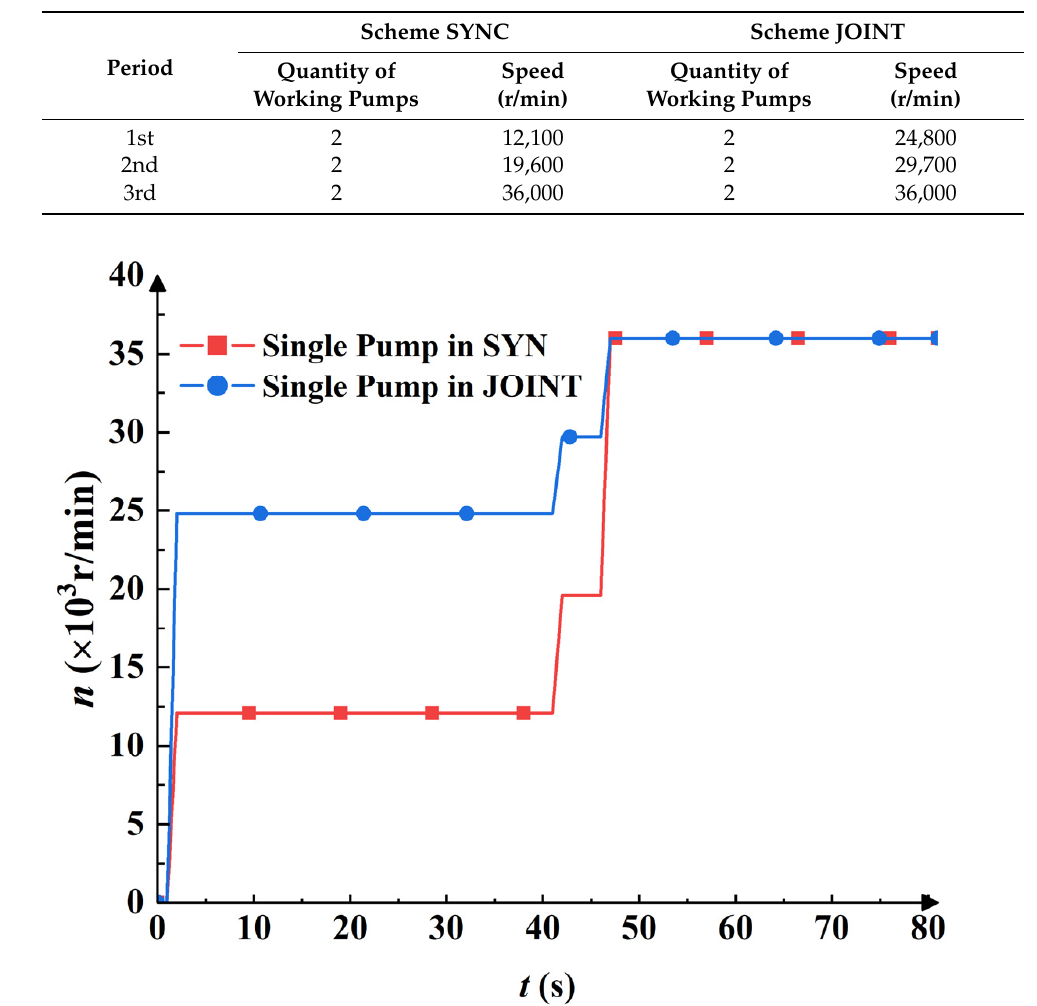
Figure 18. Pump speed between Scheme SYNC vs. Scheme JOINT.